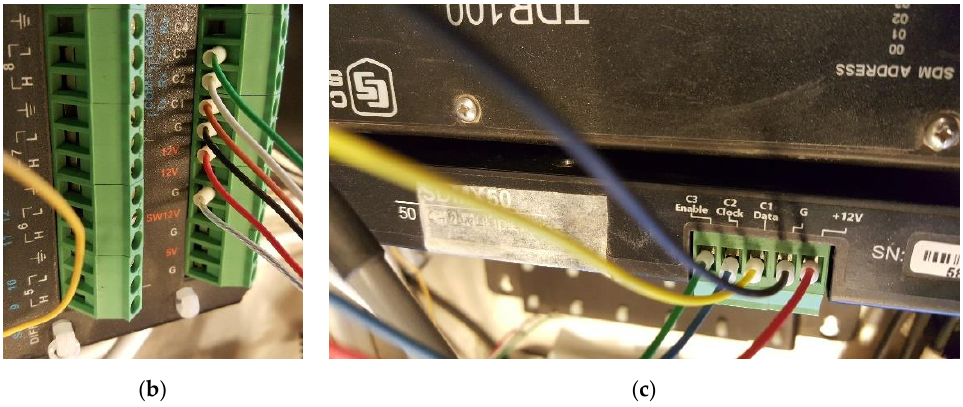
Figure 14. The spatial TDR data logging system: ( a ) the entire data logging system consists of a CR1000 datalogger connected to a TDR 100 pulse generator/receiver and SDM X50 multiplexer having eight channels available for four FRC sensors; ( b ) the data wire configuration on CR1000 data logger; ( c ) the data wire configuration on TDR 100 device and the SDM X50 multiplexer.